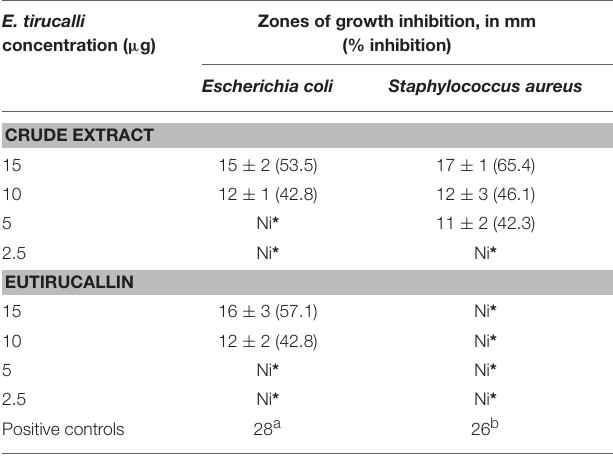
TABLE 4 | Antimicrobial activity of Euphorbia tirucalli crude extract and Eutirucallin demonstrated by the agar diffusion technique. E. tirucalli concentration ( µ g)